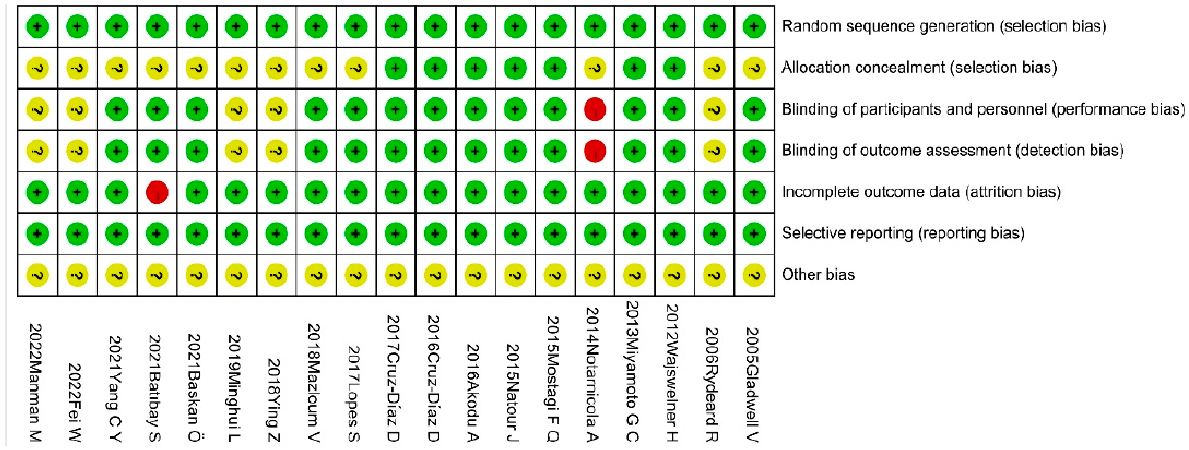
Figure 2. Résumé of results of risk of bias assessment.